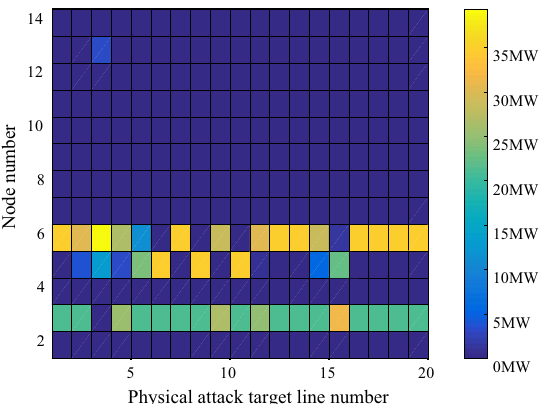
Fig. 10 Load reduction distribution by attacking different